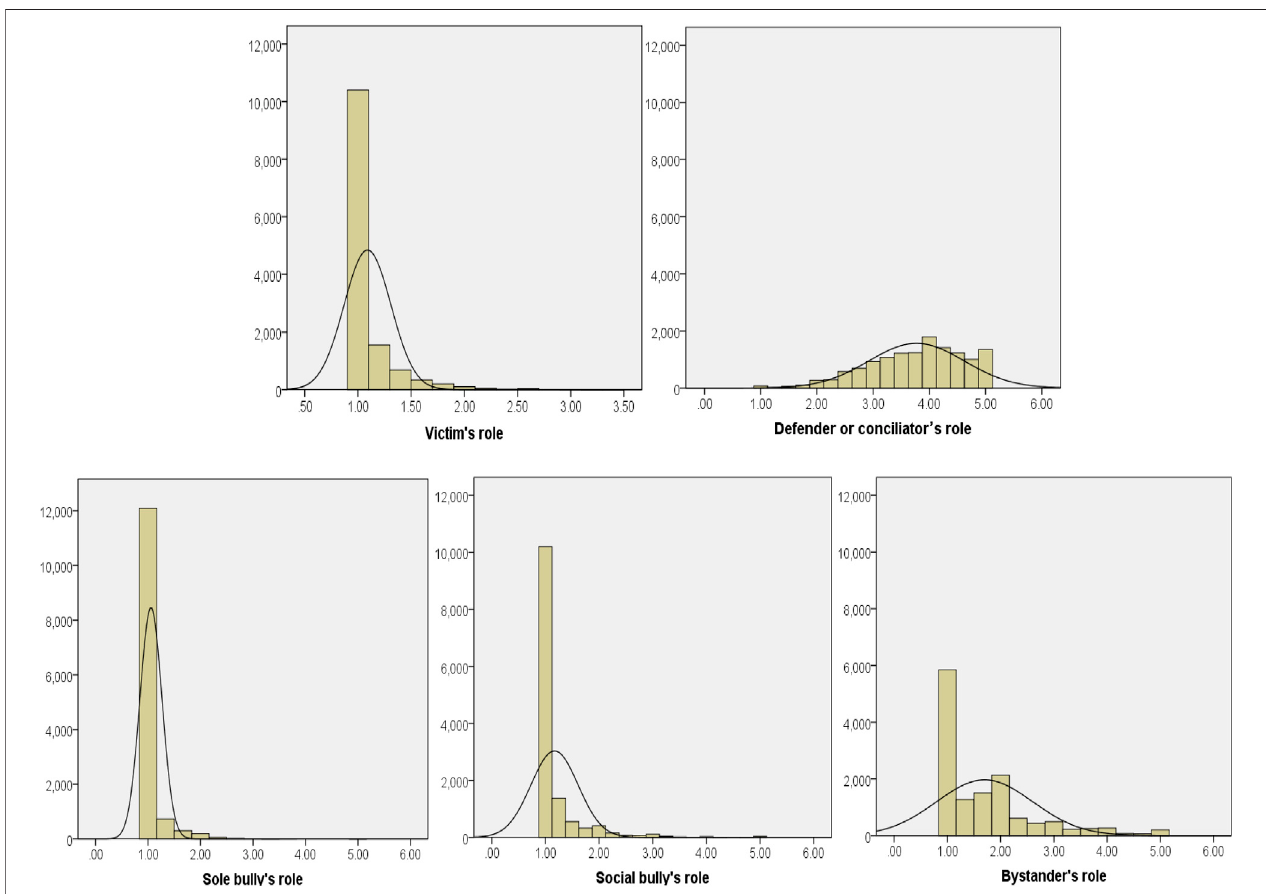
FIGURE1| Distributionofmean scoresofeach subscale ofERECVE Note . Mean scoresoftheERECVE subscaleswere: forthe victim ’ srole , 1.09(SD (cid:1) 1.06); for the defender ’ s or conciliator ’ s role , 3.77 (SD (cid:1) 1.25); for the sole bully ’ s role , 1.05 (SD (cid:1) 0.28); for the social bully ’ s role , 1.17 (SD (cid:1) 0.60); and for the bystander ’ s role , 1.70 (SD (cid:1)